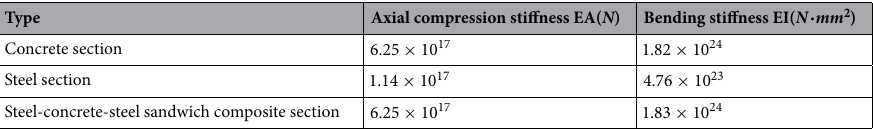
Table 2. Comparison of section stiffness of different types of